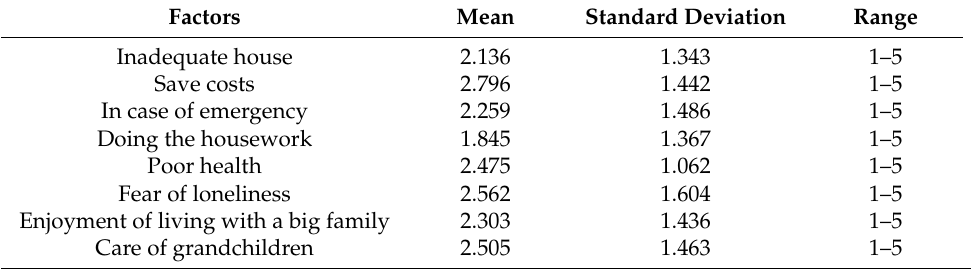
Table 4. Characteristics of sample (N =